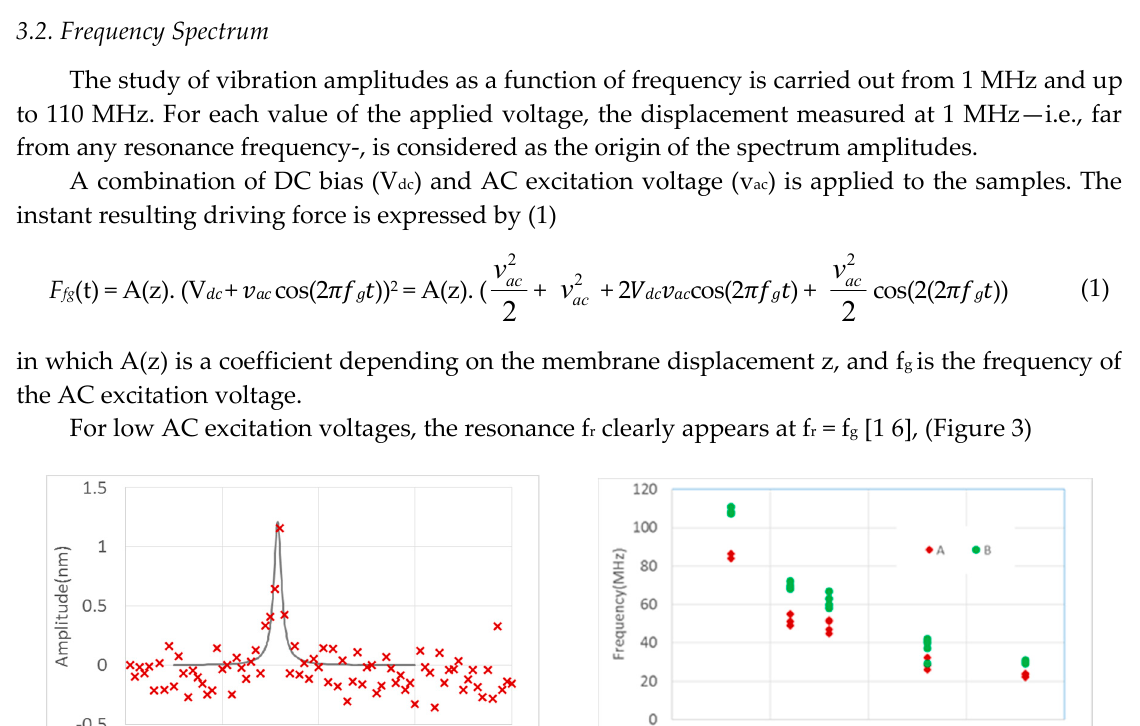
Figure 2. AFM Measurements of the displacement of a point of the membrane versus time at low frequency. ( a ) with frequency set at 5 Hz, and various AC voltage amplitudes; ( b ) with AC voltage amplitude set at 16 V, and various low frequencies. The operation of this measurement set up appears limited at frequencies lower than 100 Hz.